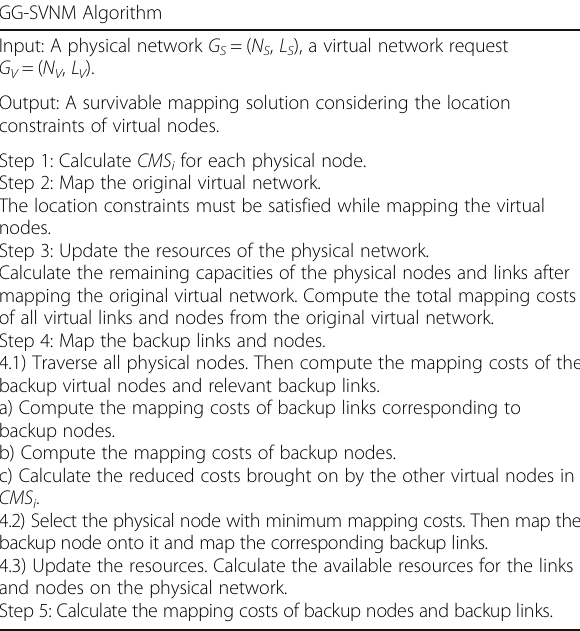
Table 2 Pseudo code of GG-SVNM algorithm GG-SVNM